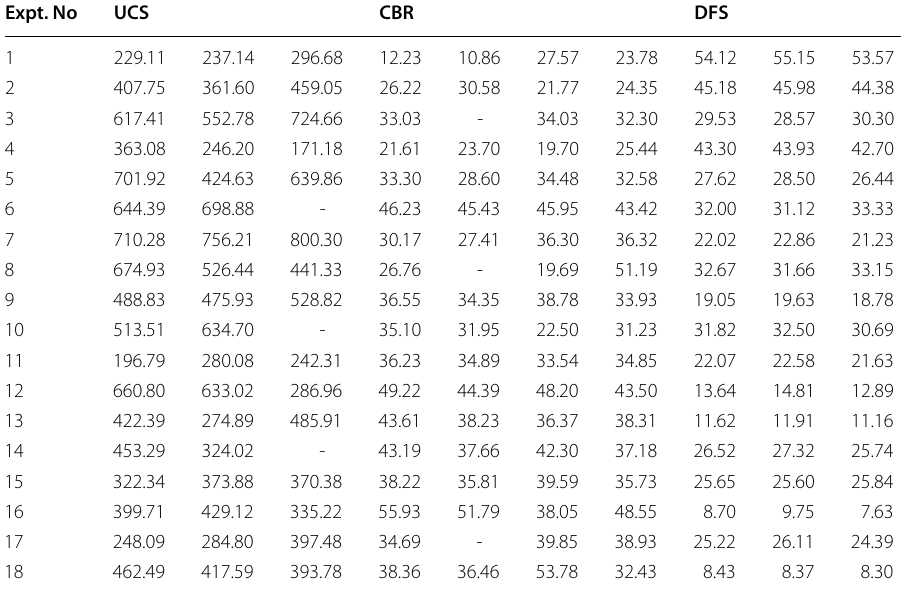
Table 5 Experimental data